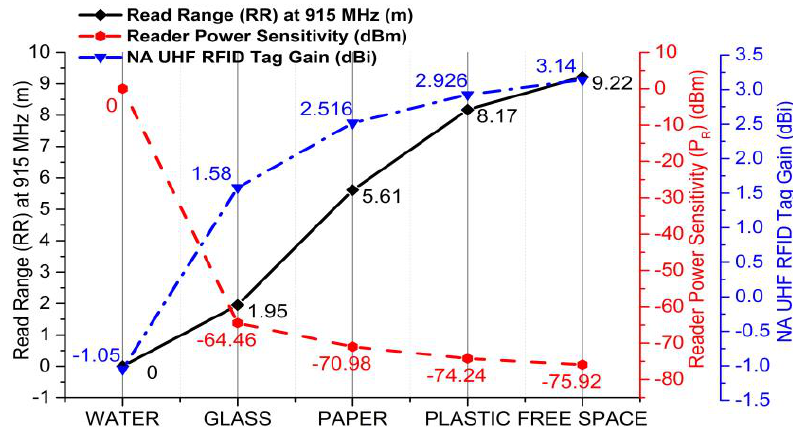
Figure 16. Tag gain read range (RR) and reader power sensitivity ( P R ) of NA UHF RFID tag on mounting platforms and in free space.